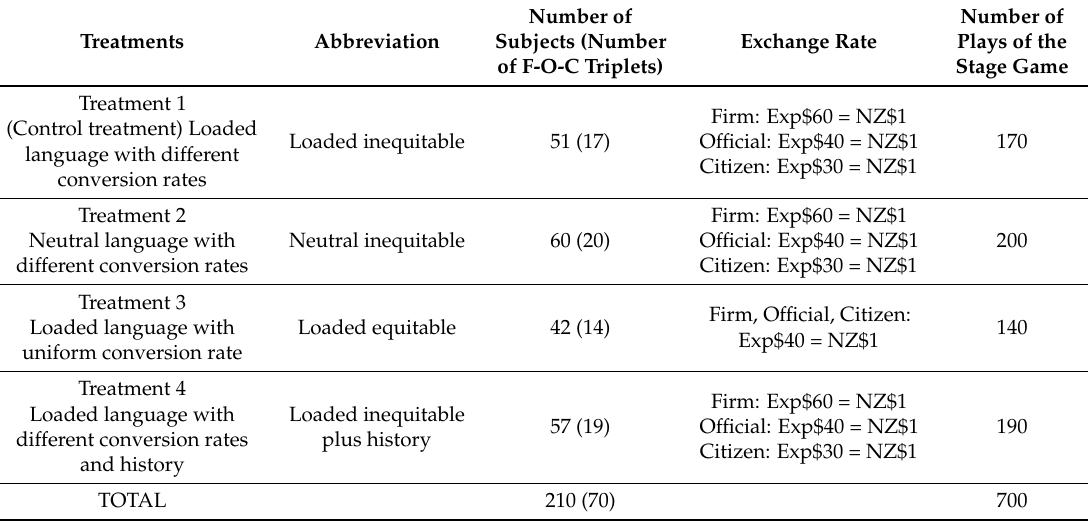
Table 1. Summary of experimental